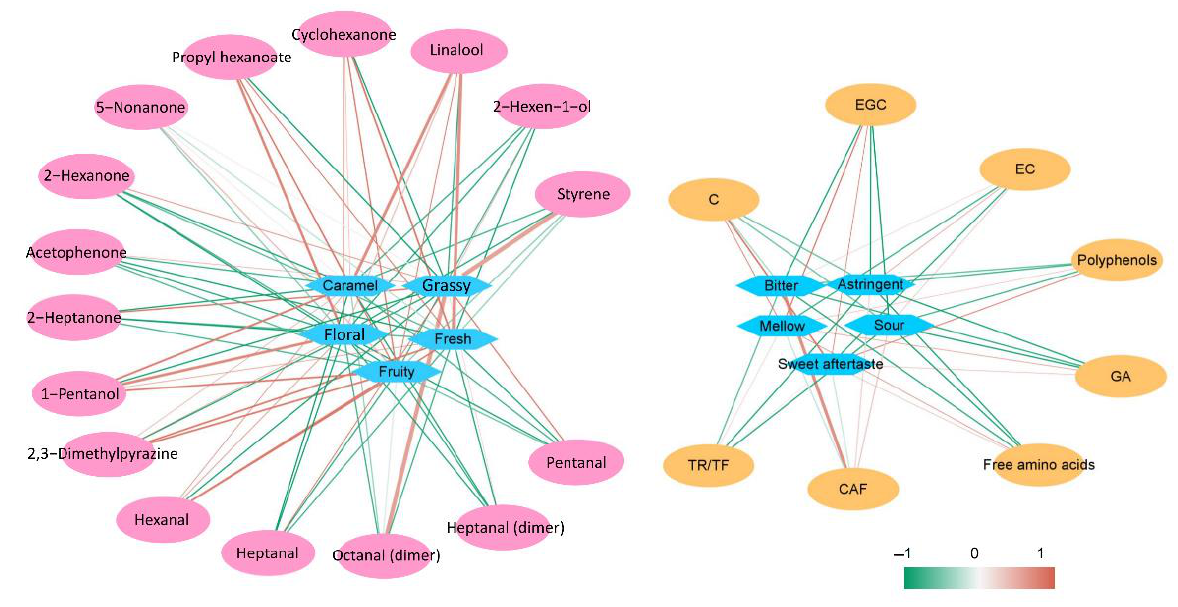
Figure 7. The correlation network between different VOCs, biochemical compositions, and sensory characteristics of different grades of PCT. The diamond represents the taste and aroma, and the ellipse represents the VOCs and biochemical compositions. The red line indicates a positive correlation, the green line indicates a negative correlation, and a darker color indicates a stronger correlation.